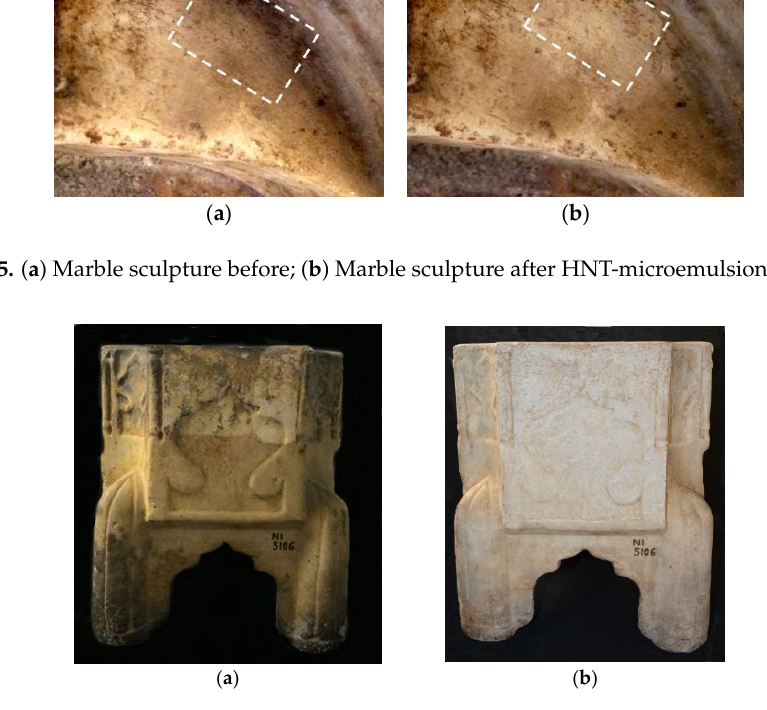
Figure 6. ( a ) A full view of the Kilga artifact before; ( b ) A full view of the Kilga artifact after the cleaning treatment.